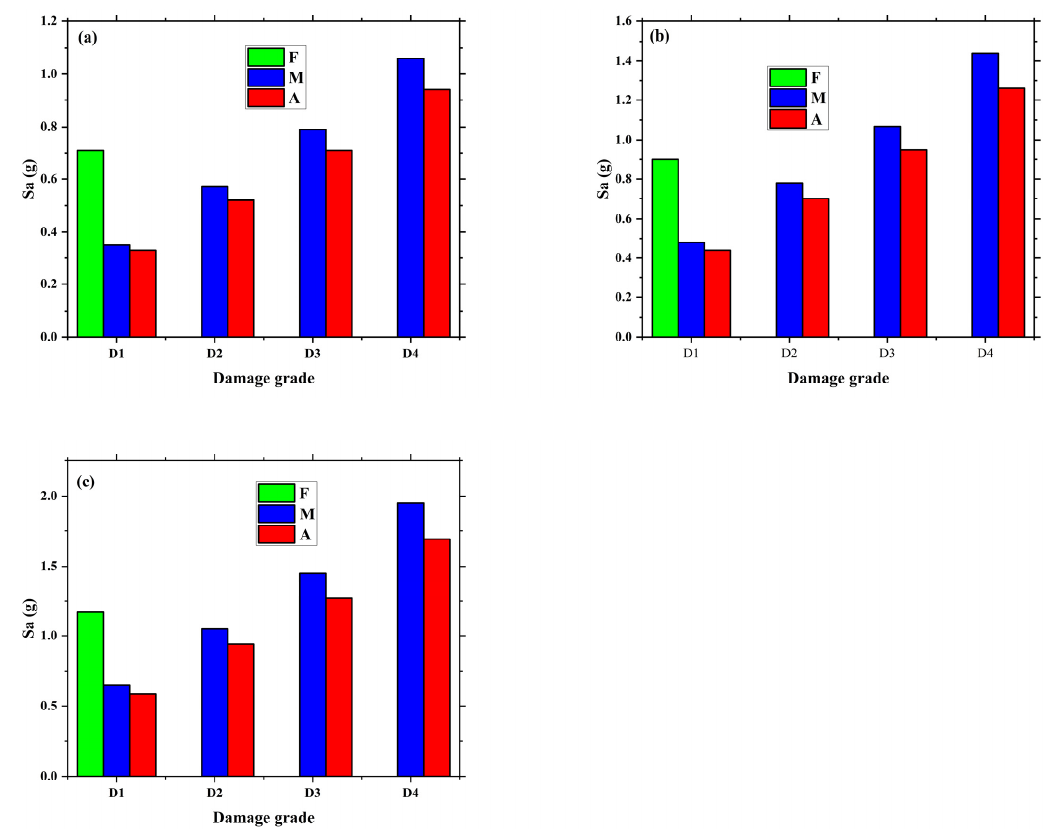
Figure 12. Corresponding spectral accelerations for four damage states for ( a ) 25% probability of exceedance, ( b ) 50% probability of exceedance, and ( c ) 75% probability of exceedance. F, M, and A within the parentheses indicate foreshock, foreshock–mainshock, and foreshock–mainshock–after- shock time history.